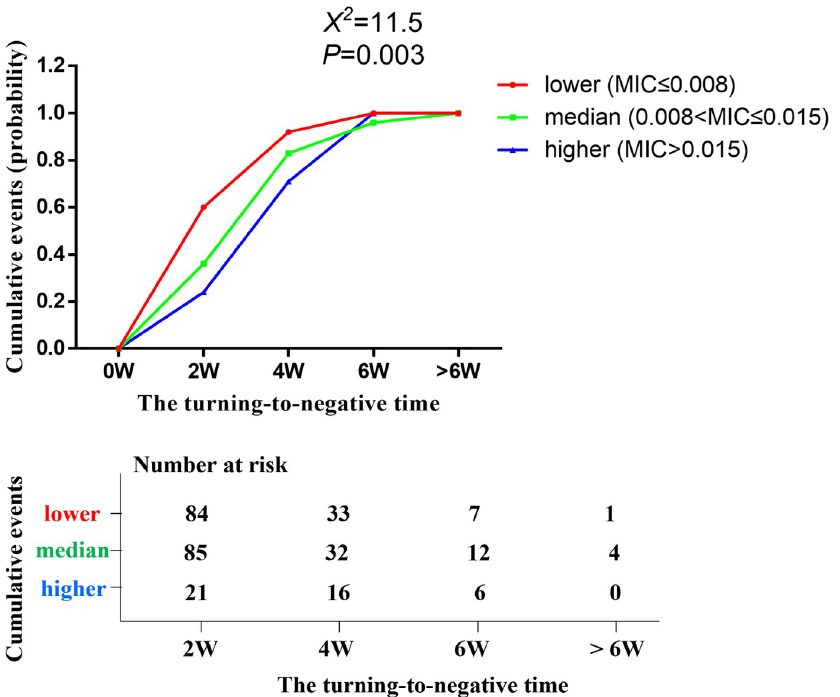
Fig 2. The MIC values of voriconazole might affect the clearance of T . marneffei in blood cultures among AIDS patients with talaromycosis after antifungal therapy. Strains from 190 patients were split into three groups according to the MIC values for voriconazole in vitro : lower (MIC � 0.008), medium (0.008 < VOA � 0.015), and higher (VOA > 0.015). Cumulative negative conversion rate of blood cultured fungi was assessed among three groups after 2, 4, 6 weeks and more than 6 weeks of antifungal treatment. P < 0.05 is considered statistically significant. https://doi.org/10.1371/journal.pntd.0011201.g002 Table 2. Antifungal drug susceptibility of T . marneffei strains from 190 patients with AIDS and talaromycosis. Antifungal